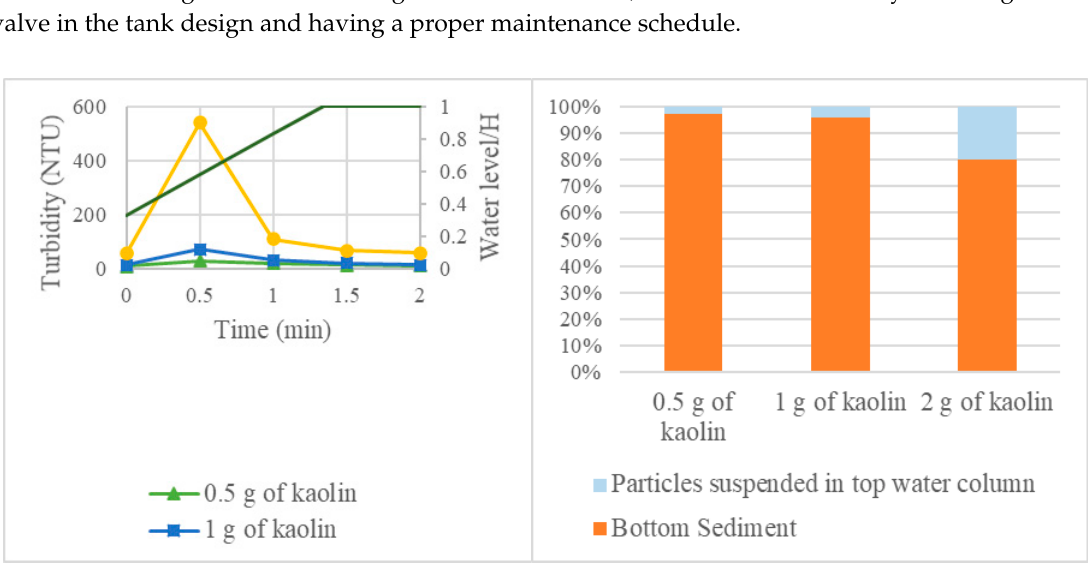
Figure 7. Turbidity variation and kaolin mass distribution for different doses of kaolin clay (J type inlet).